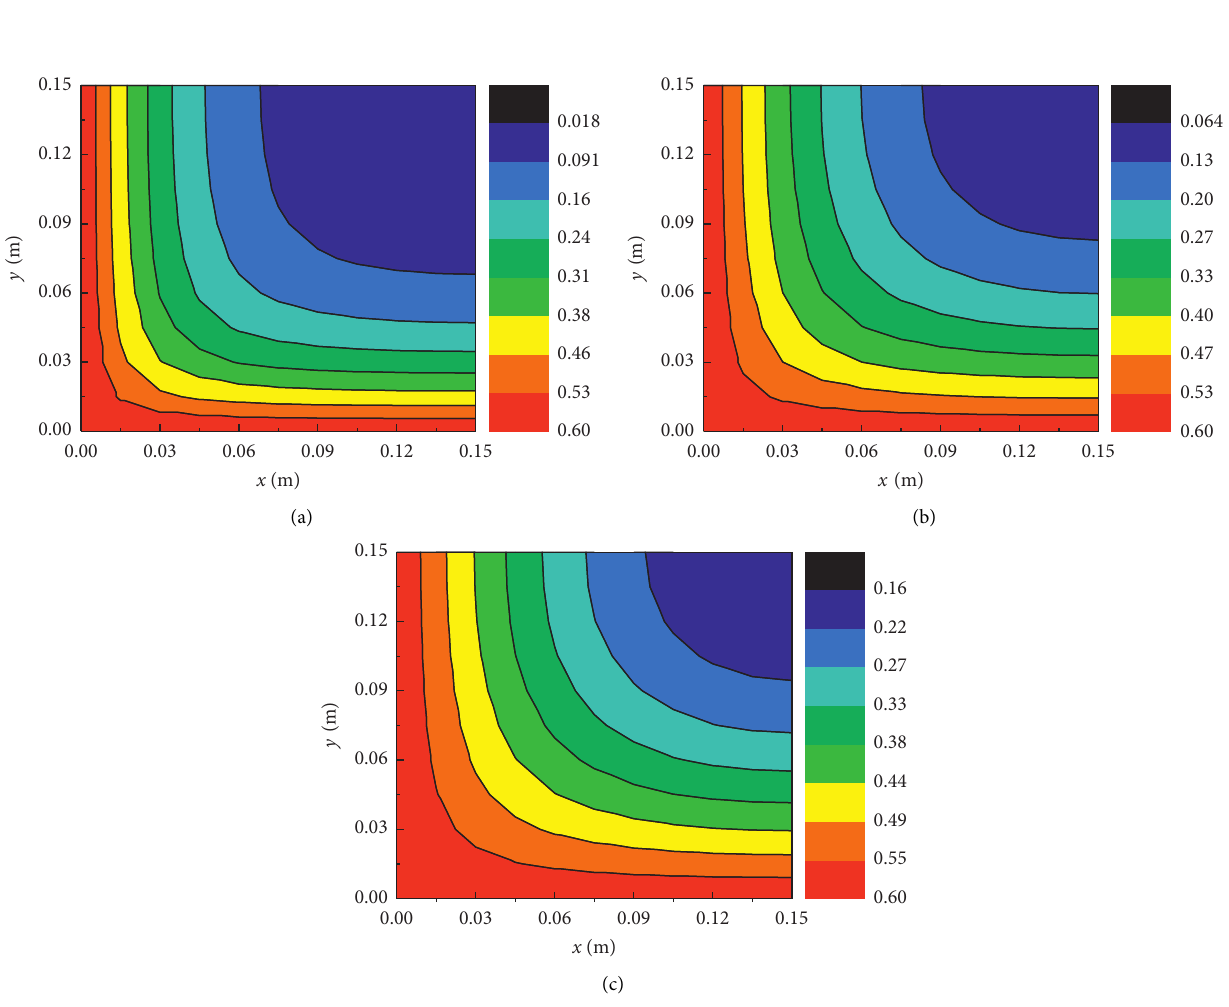
Figure 5: Distribution of chloride concentration ( t � 20 years). (a) α � 0.4, (b) α � 0.6, and (c) α � 0.8.